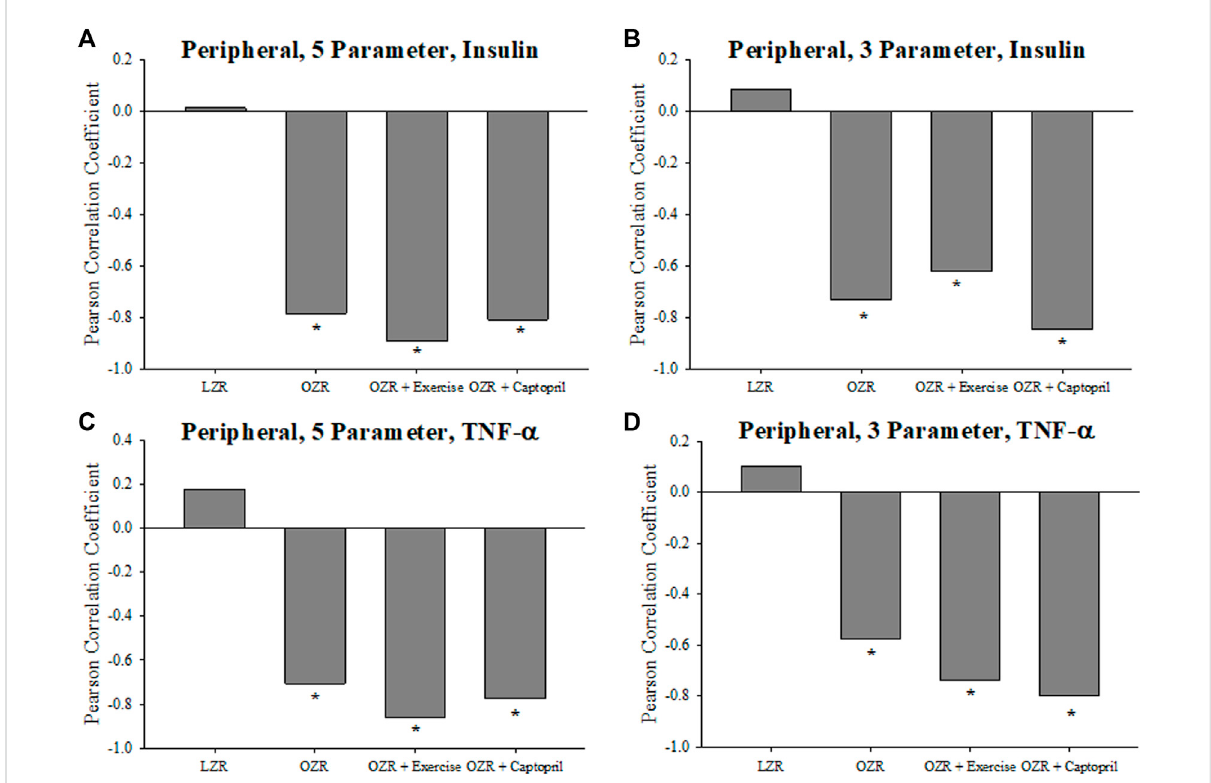
FIGURE 6 Data (mean ± SE) describing the criterion validity between plasma insulin or TNF- α and the skeletal muscle Vascular Health Index (VHI) in the present study. The Pearson Correlation Coef fi cient between insulin and VHI in LZR and OZR are summarized in Panels (A) (5-parameter VHI) and (B) (3-parameter VHI). Panels (C) (5-parameter VHI) and (D) (3-parameter VHI) present the Pearson Correlation Coef fi cient between plasma TNF- α and skeletal muscle VHI in LZR and OZR. Also presented are the correlations between plasma insulin or TNF- α and VHI in OZR following intervention with chronic exercise or captopril treatment. * p < 0.05 vs. LZR at that age; † p < 0.05 vs. OZR at that age. Please see text for